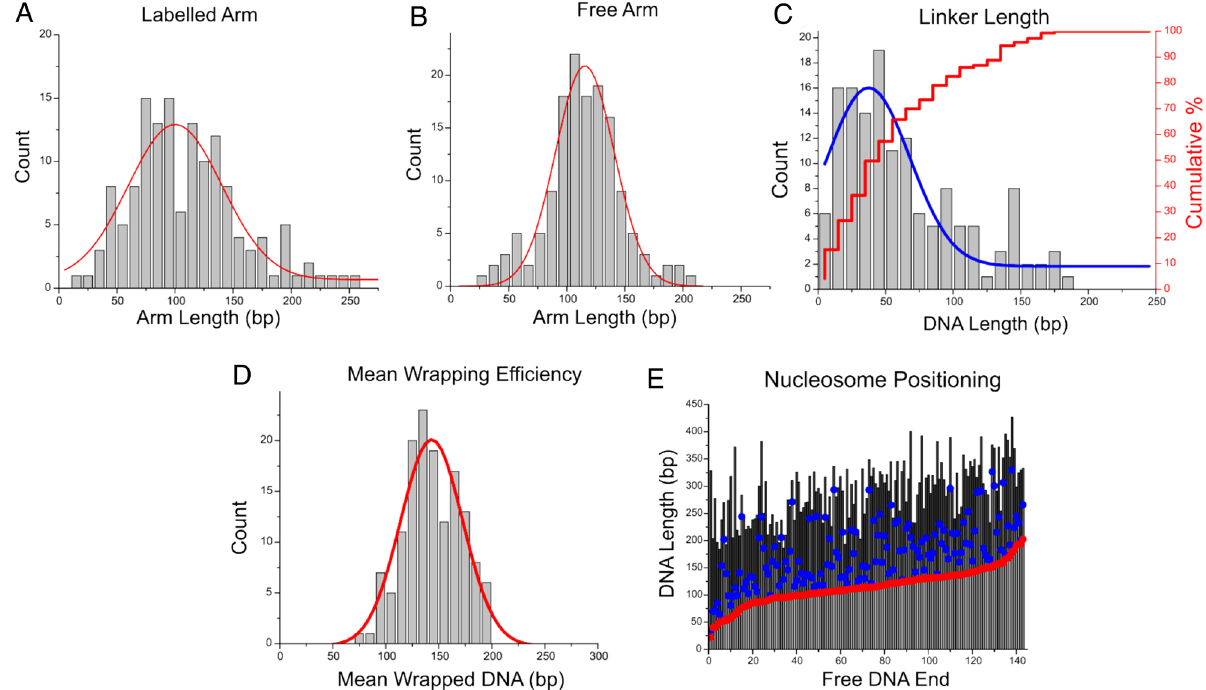
Figure 7. Analysis of modified dinucleosomes with the H4 histone tail truncated assembled on the dinucleosome substrate with one positioning motif. Histograms ( A , B ) depict the labelled and free arm lengths, respectively. The labelled arm shows a broad distribution with mean value of 112 ± 4 bp (SEM), while the free arm has a mean value of 115 ± 3 bp (SEM). Note that the 601 motif is positioned at the end of the free arm. ( C ) Histogram of the linker length between two nucleosomes. Mean linker length value is measured as 64 ± 4 bp (SEM), while a Gaussian fit shows a peak centered at 37 ± 30 bp (SD). Histogram ( D ) reveals a mean wrapping efficiency of 144 ± 2 bp (SEM), indicative of fully wrapped nucleosomes. ( E ) Positional mapping of modified dinucleosomes demonstrates a preference for nucleosomes to be proximal to one